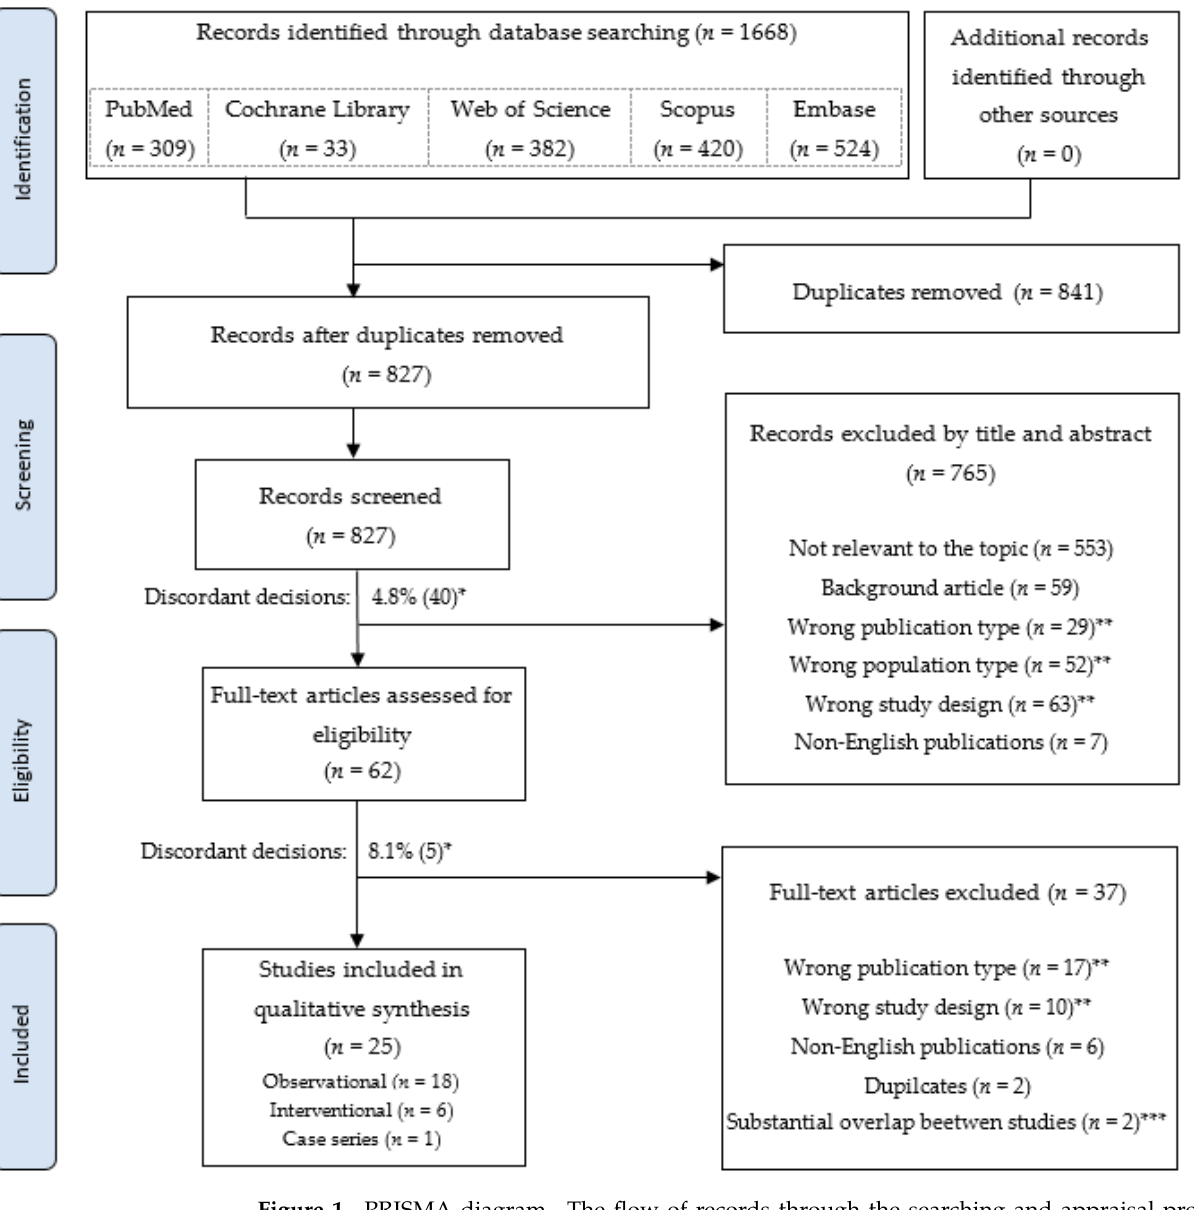
Figure 1. PRISMA diagram. The flow of records through the searching and appraisal process. * percent (number) of discordant decisions between investigators, resolved by consensus. ** according to the criteria presented in Table 1. *** based on additional data obtained from the author.